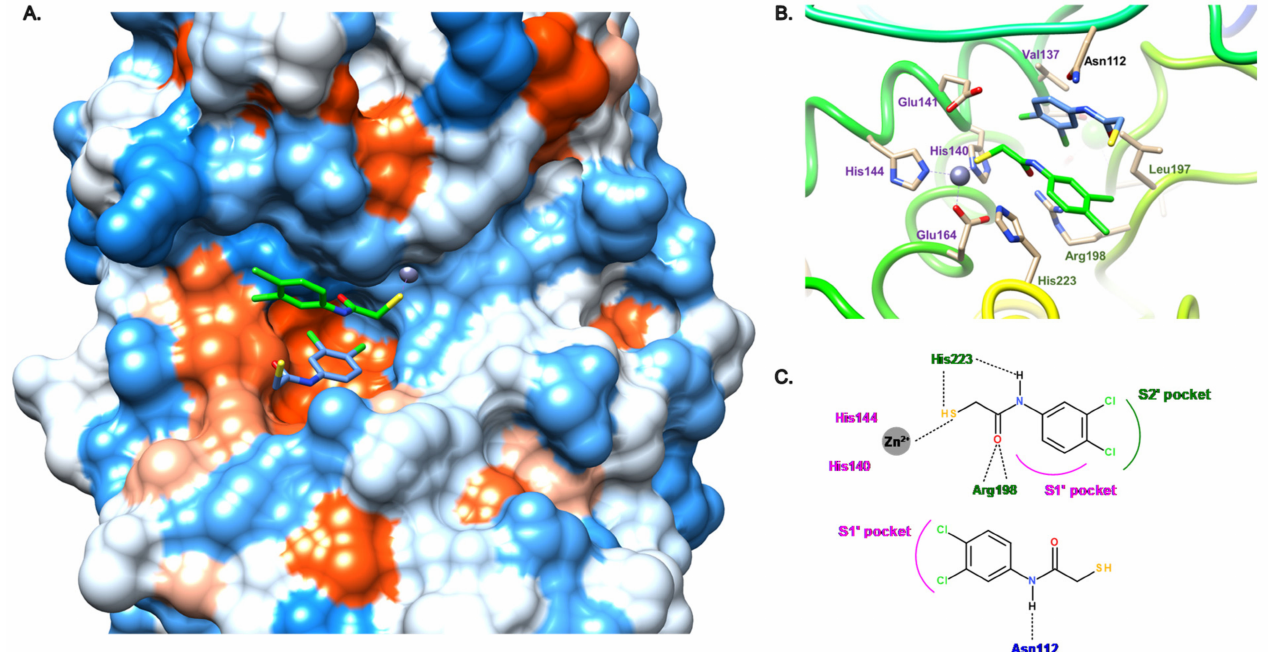
Figure 7. Binding mode of 11 from PDB entry 6F8B [30]. ( A ) View of the active site of LasB, in surface mode, accommodating 11a (green) and 11b (dark blue) visualized using Chimera 1.15. The zinc cation is represented as a gray sphere. ( B ) View of the active site of LasB with 11a (green), 11b (dark blue) and key residues (gray sticks) involved in the binding visualized using Chimera 1.15. ( C ) Two-dimensional schematic representation of the binding mode of 11a (top) and 11b (bottom). The key interactions are indicated as dashes, the zinc cation is represented as a gray sphere, and the key residues are indicated in pink for those belonging to the S1 (cid:48) pocket, green for those belonging to the S2 (cid:48) pocket and blue for the